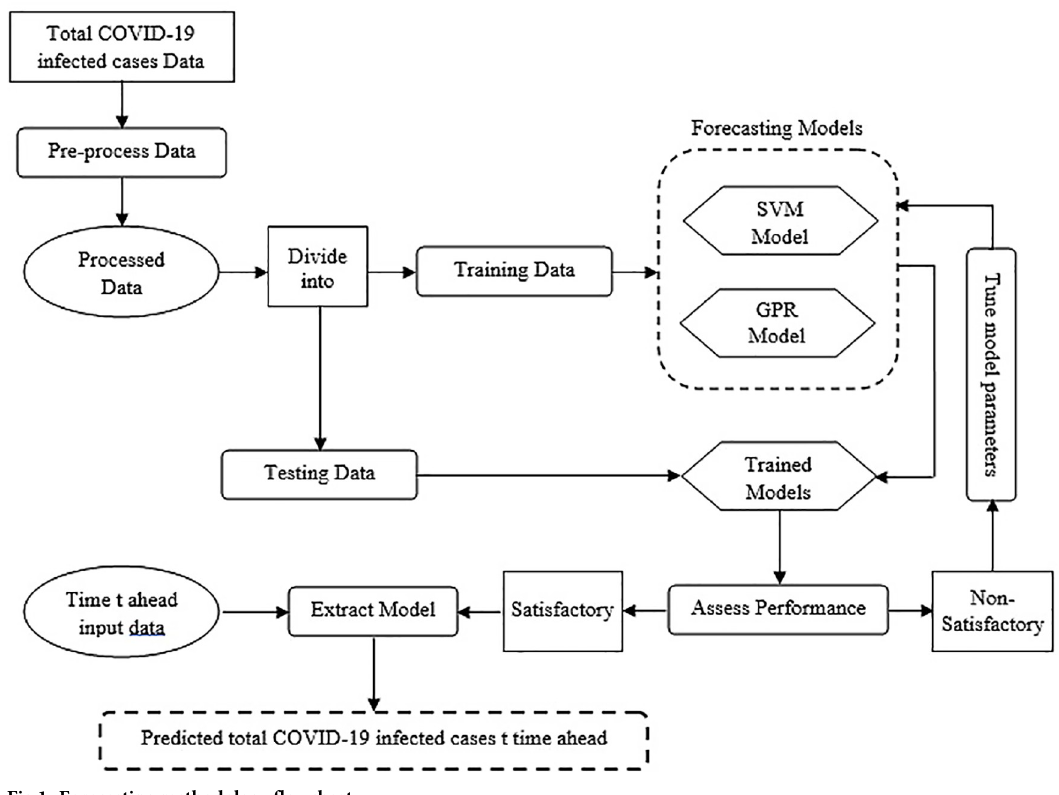
Fig 1. Forecasting methodology